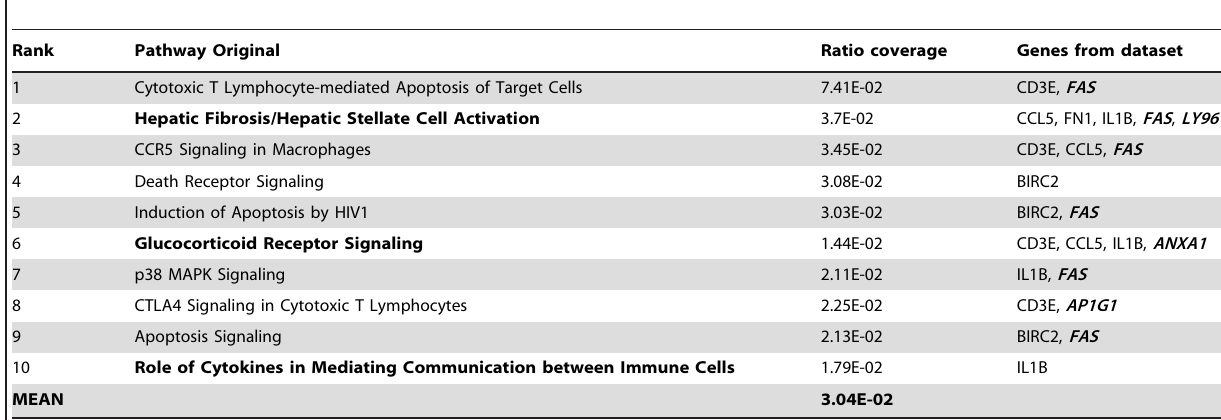
Table 6. Top 10 significant pathways re-annotated differentially expressed mRNA